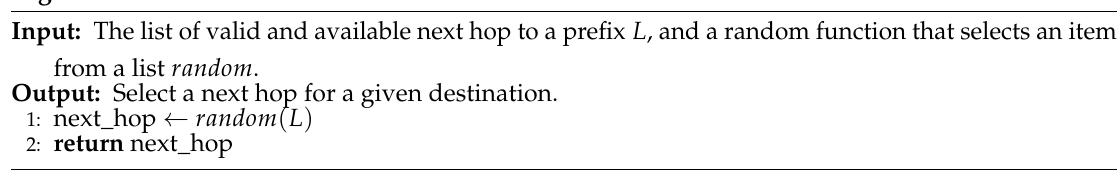
Algorithm 1 Reactive Random Load